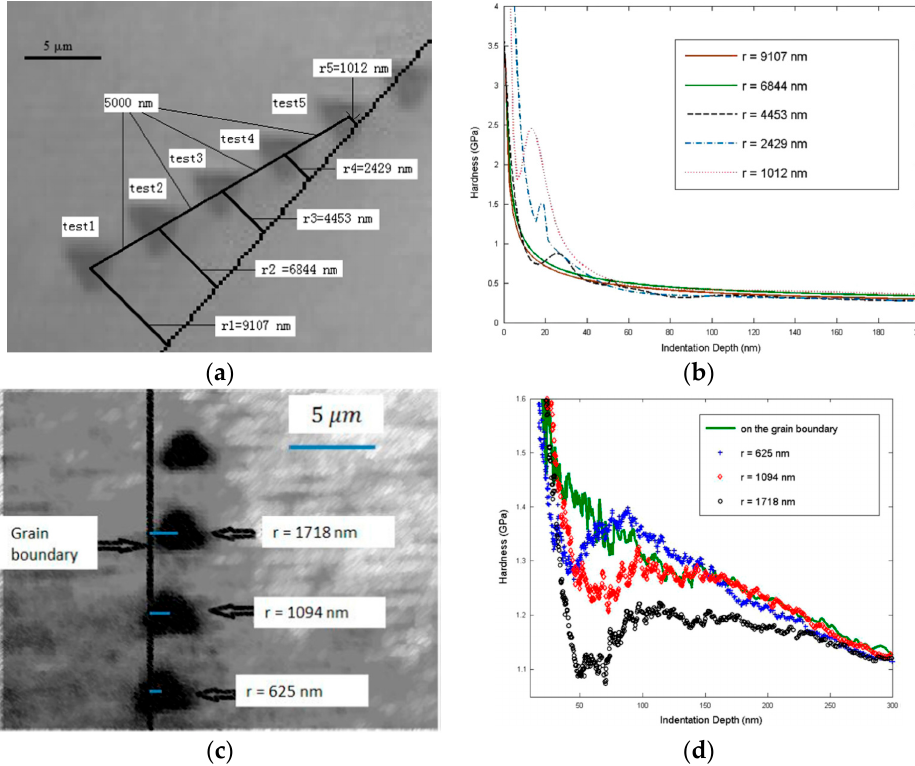
Figure 11. Effect of grain boundary on the nanoindentation response of crystalline metals: ( a ) distances between the grain boundary and indentations for Al bicrystal sample; ( b ) the effect of the distance from indentation to the grain boundary on the nanoindentation response of the Al bicrystal sample; ( c ) distances between the grain boundary and indentations for the Cu bicrystal sample; ( d ) the effect of the distance from indentation to the grain boundary on the nanoindentation response of the Cu bicrystal sample (after Voyiadjis and Zhang [107] and Zhang and Voyiadjis [108]).